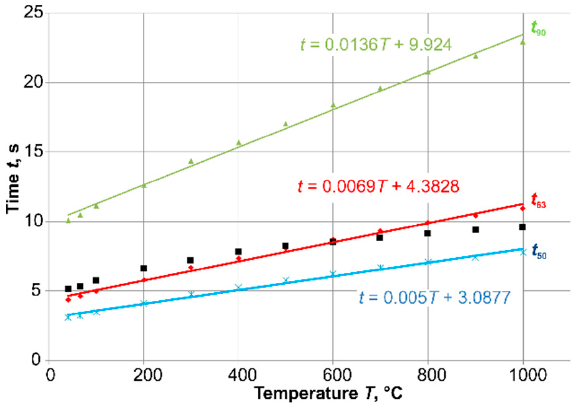
Figure 5. FEA results for steps from different temperatures to T = 20 °C.